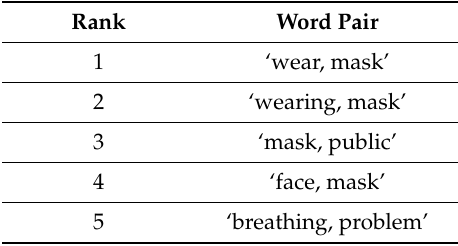
Table 5. Top 5 word pairs. Filtered by